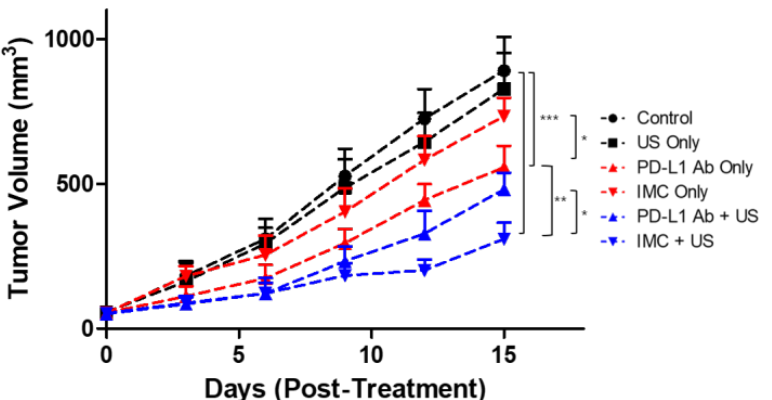
Figure 5. The therapeutic efficacy of PD-L1 targeting protocols against CT26 colon tumors. The con- trol, ultrasound (US) only, and IMC only groups did not show any regression of the tumor after treatment protocols were employed. As expected, the administration of PD-L1 antibody was effective in retarding the tumor growth. The therapeutic effects were maximized with the combination of IMC with focused ultrasound treatment, from which the synergistic effects of both the enhanced localization of the PD-L1 antibody and the cavitation induced by the focused ultrasound can be expected. Values are mean ± SD ( n = 5). * p ≤ 0.05, ** p ≤ 0.01, *** p ≤ 0.001.